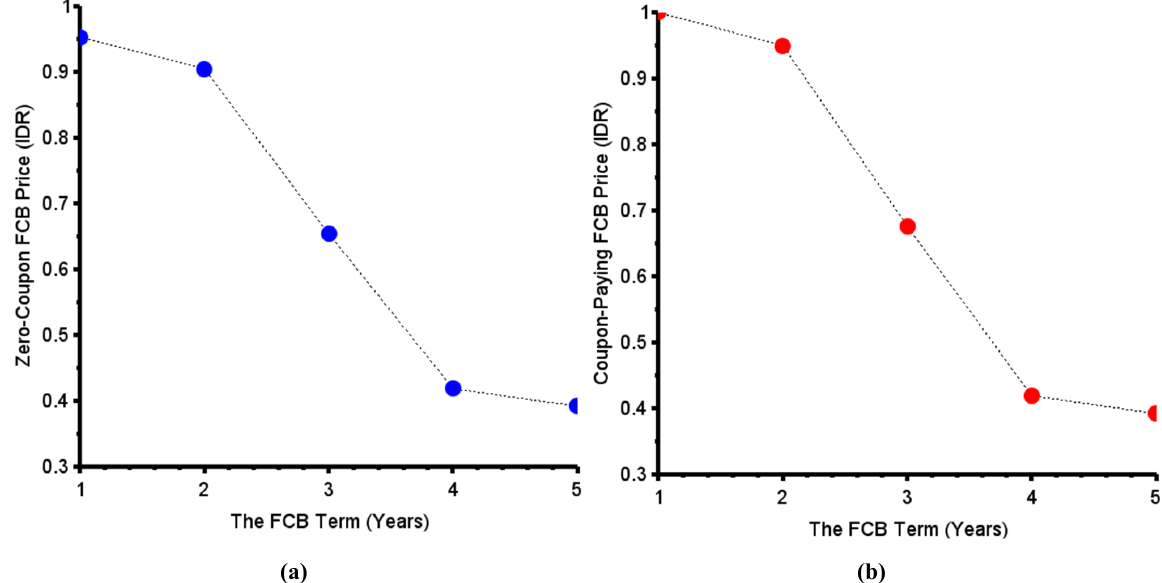
Fig. 4 . Zero-Coupon (a) and Coupon-Paying (b) FCB Prices for Each FCB Term in (cid:4668) 1,2, 3, 4, 5